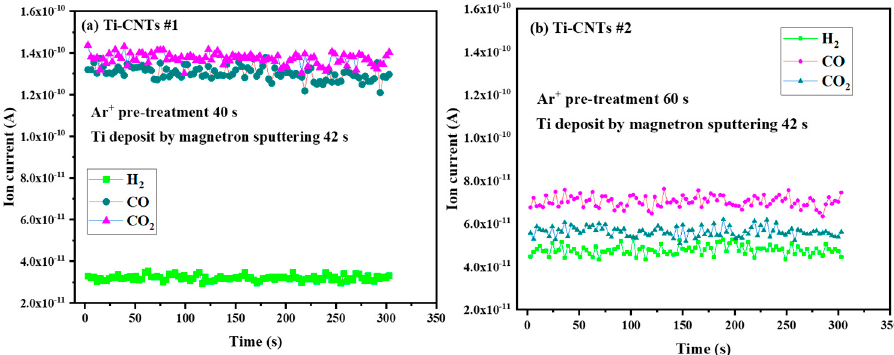
Figure 10. Background residual gas of titanium coated CNTs in UHV of 1 × 10 –6 Pa at room temperature and without FE operation. ( a ) Ti-CNTs #1, ( b ) Ti-CNTs #2.